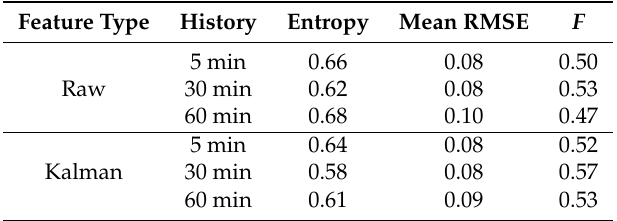
Figure 13. Performance boxplots with clustered segments and 16,000 sample size. Table 2. Performance details with clustered segments and 1000 sample